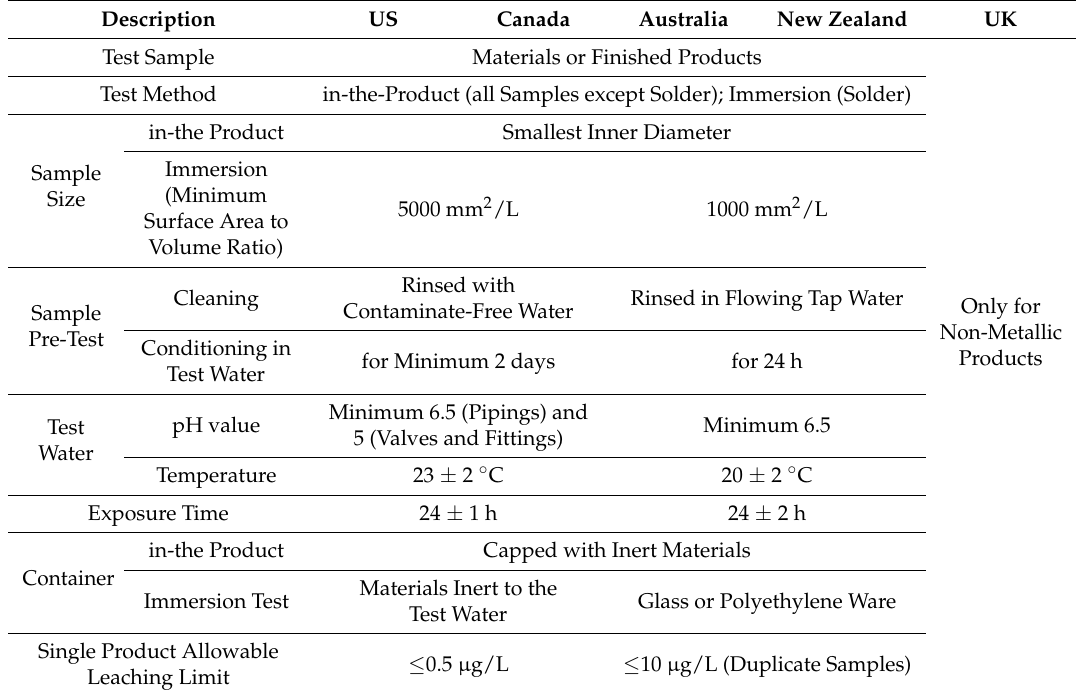
Table 3. Leaching limits and leaching test